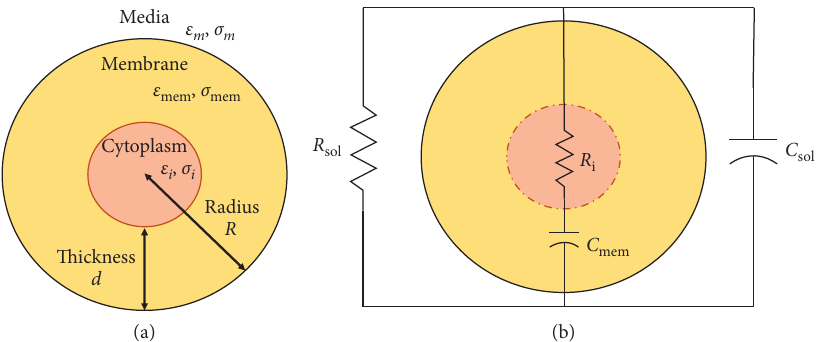
Figure 4: Schematic of the (a) cell model with single-shell, inside suspension; (b) equivalent circuit model of a cell in suspension by Foster and Schwan